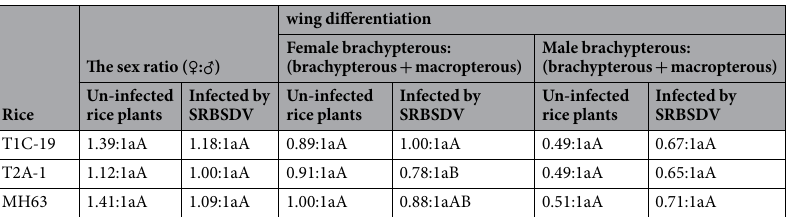
Table 5. Effects of transgenic rice plants infected with SRBSDV on the sex ratio and wing differentiation of BPH.